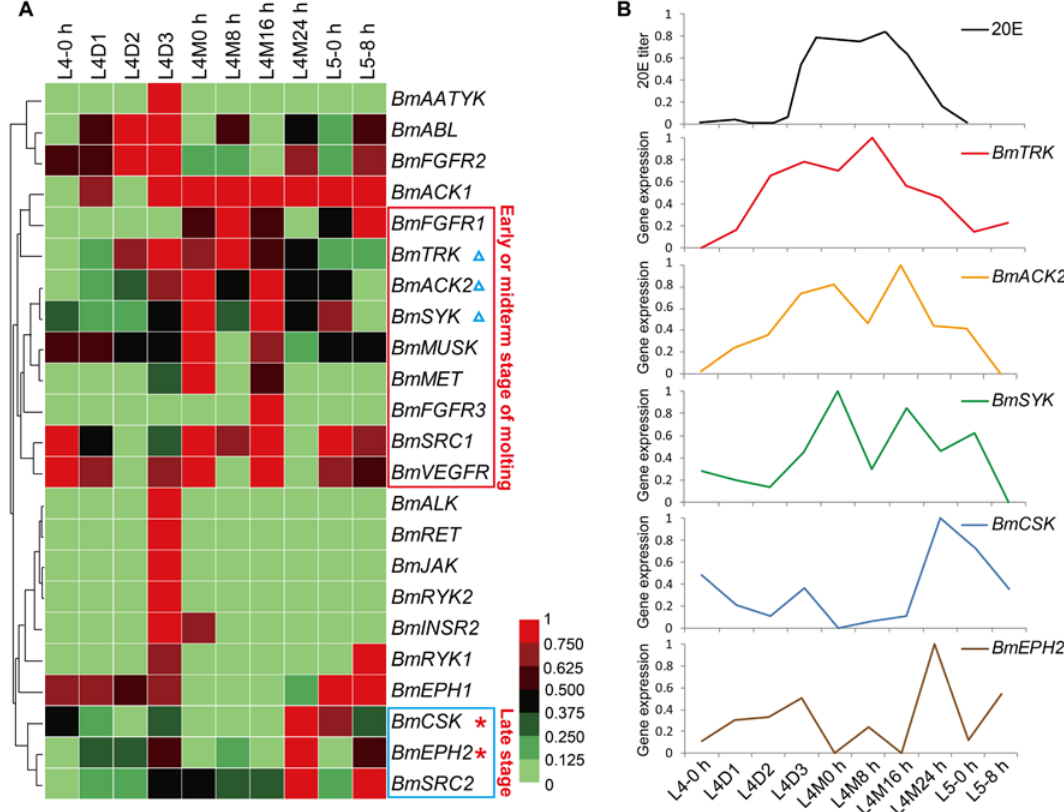
Figure 6. Microarray-based gene expression profiling of BmTK genes during the fourth larval molting. 23 BmTK genes were detected to be expressed during silkworm larval molting. L: larval (L4-0 h: beginning of the 4th larval instar, L4D1: day 1 of the 4th larval instar), M: molting (L4M0 h: beginning of molting, L4M8 h: 8 h after L4M0 h). ( A ) Red box indicates the genes with high expression at the early or midterm stage of molting. Blue box indicates the genes with high expression at late stage of molting. ( B ) The 20E titer in silkworm haemolymph (from Kiguchi et al. [46]) is shown at the top. BmTRK , BmACK2 and BmSYK are with the expression pattern resembling the pulse of 20E ( A , blue triangles). BmCSK and BmEPH2 might respond to low concentrations of 20E ( A , red asterisks).